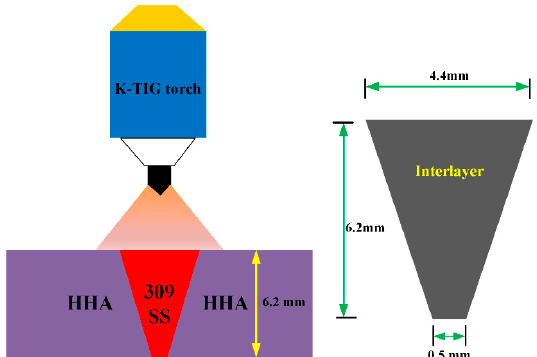
Figure 1. Microstructure of high hardness armour (HHA) base metal; ( a ) low magnification of scanning electron microscope (SEM); and ( b ) high magnification of SEM.